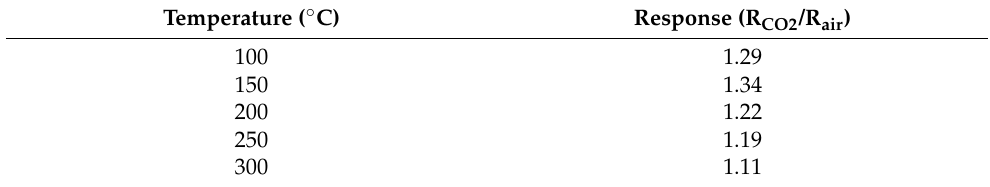
Table 6. ITO:Zn/Si film sensor response at 1000 ppm CO 2 for different operating temperatures. Temperature ( ◦